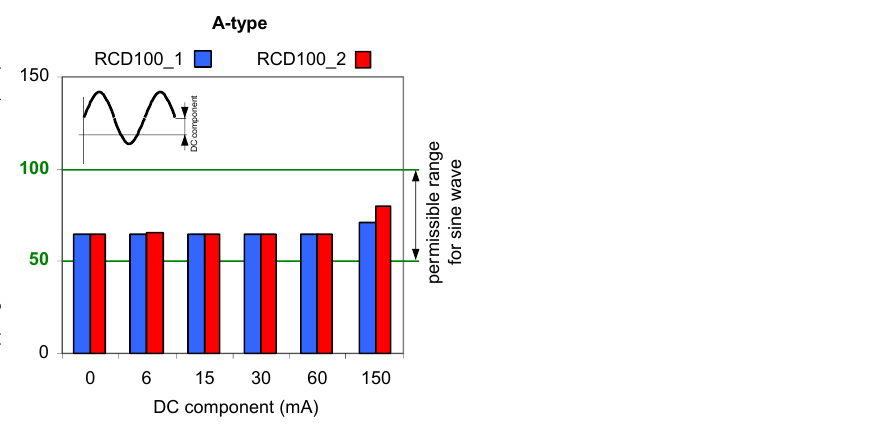
Figure 7. Tripping current (rms value of the AC sinusoidal component) of two 100 mA A-type RCDs under AC sinusoidal current superimposed by smooth DC component of values 6, 15, 30, 60, and 150 mA.